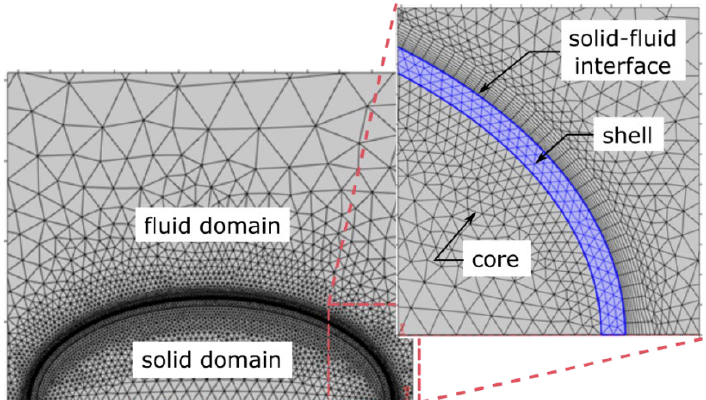
Figure 4. The computational domain and mesh. The 2D axisymmetric mesh of the solid domain, the solid–fluid interface, and the fluid domain. The solid domain includes the bean core and shell.